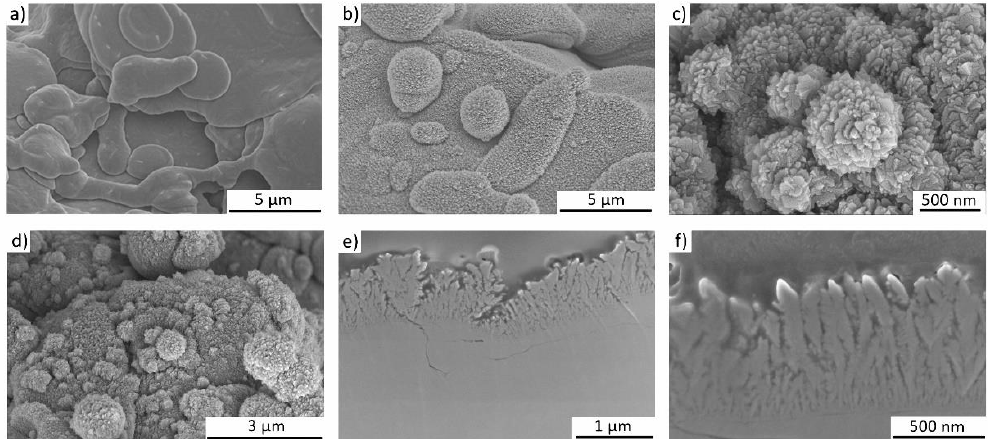
Figure 2. Representative SEM images of the implant surface ( a , d ) of the reference TPS sample with microscale roughness. In ( b – d ) SEM images of TPS+ samples with the additionally nanostructured surface after GLAD deposition are shown. The homogeneity of the nano-spikes over a wide area from the top view is shown in ( b , d ) and in greater detail sharp nanospikes are shown on solidified spherical droplets ( c ). In ( e , f ) images of the cross sections of the TPS+ samples with columnar-like structures are shown.